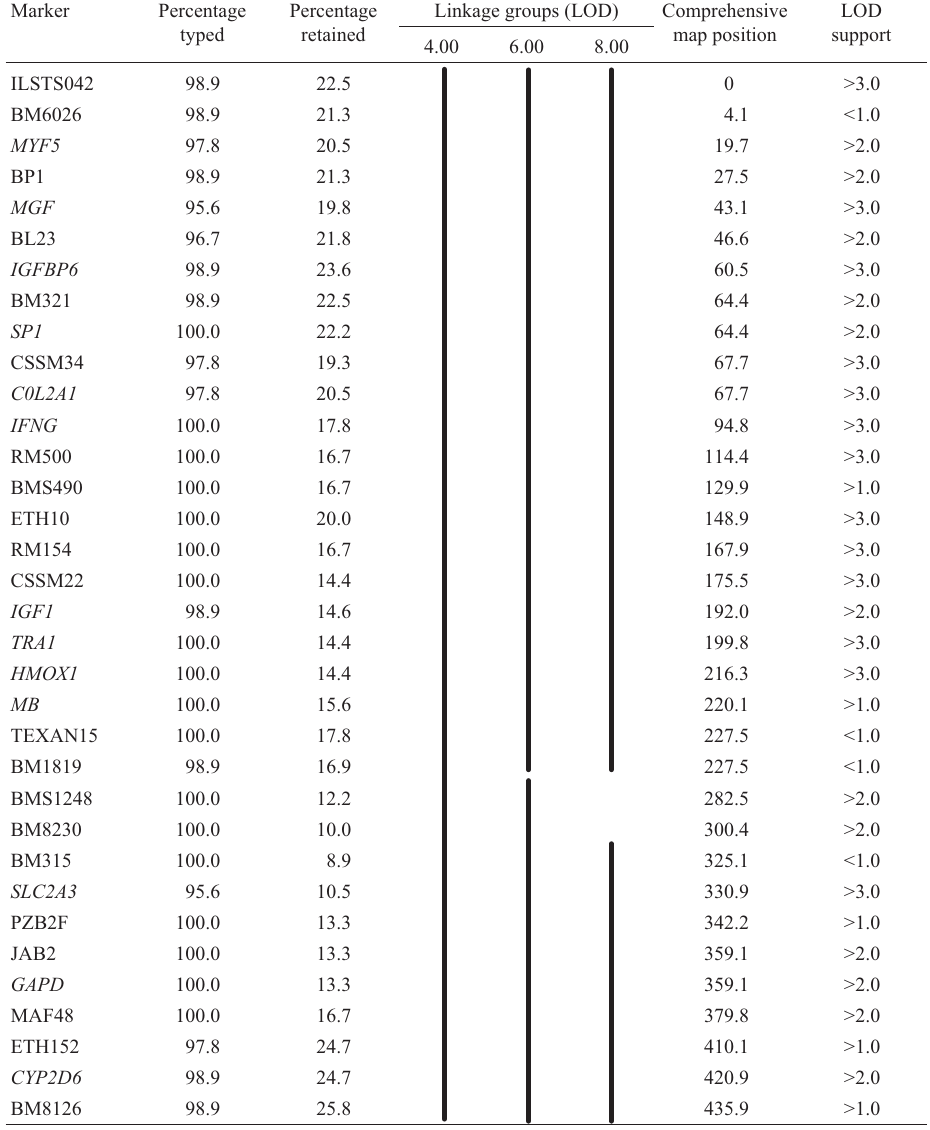
Table 2 - Features of the RH map of BTA5. The percentage of lines typed is for the lines with + or - scores. Linkage groups formed in the 2-point analysis at different LOD supports are represented by bars. The position of the markers is according to the order in the comprehensive map, which represents the most likely marker order obtained with no LOD support